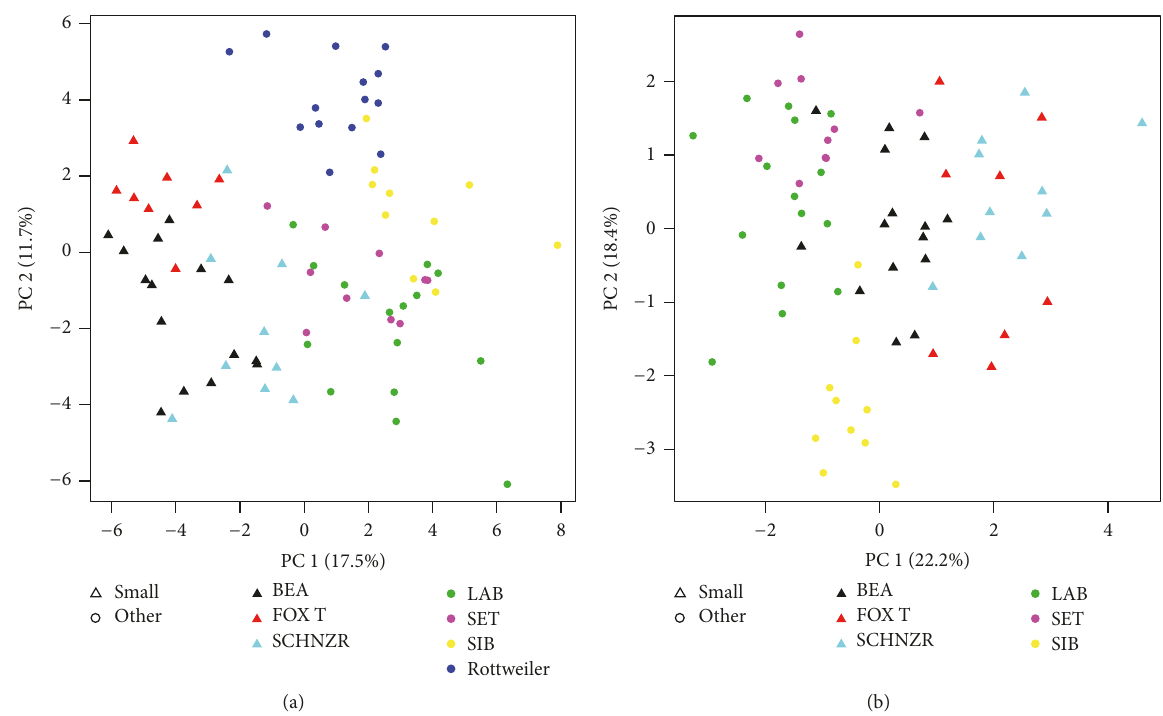
Figure 2: Principle component analysis using selected metabolites (a) and clinical parameters (b) between small dogs and dogs of larger (other) body size. Note that Rottweilers were not considered in the PCA generated with clinical parameters as they are missing DEXA- related parameters along with thyroid hormones T3 and T4. Body size is indicated by triangle (small) or circle (larger, other). LAB, Labrador Retriever; SET, English Setter; BEA, Beagle; FOX T, Small Fox Terrier; SIB, Siberian Husky; SCHNZR, Miniature Schnauzer.